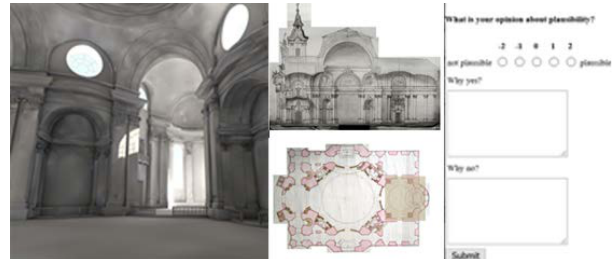
Figure 11. Survey front